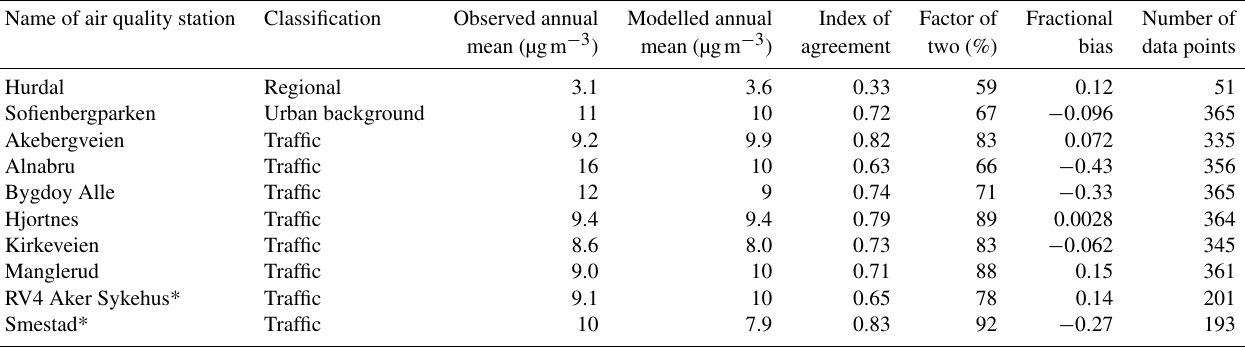
Table C3. Selected statistical parameters for the agreement of predictions and measurements for the daily concentrations of PM 2 . 5 in the Oslo area in 2013.